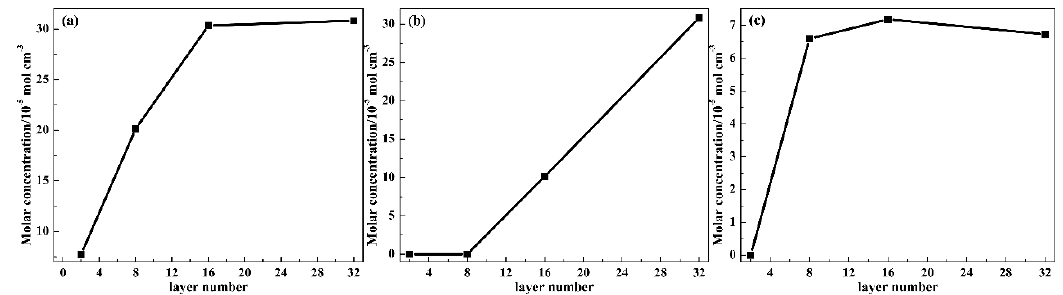
Figure 6. ( a ) Intermolecular C HBs between the phenolic O–H group in AO-70 and the ester C=O group in the soft segment of TPU; ( b ) intermolecular C HBs between the phenolic O–H group in AO-70 and the ester C=O group in PVAc and ( c ) intermolecular C HBs between the urethane N–H group in the hard segment of TPU and the ester C=O group in PVAc of TP system at 298 K.